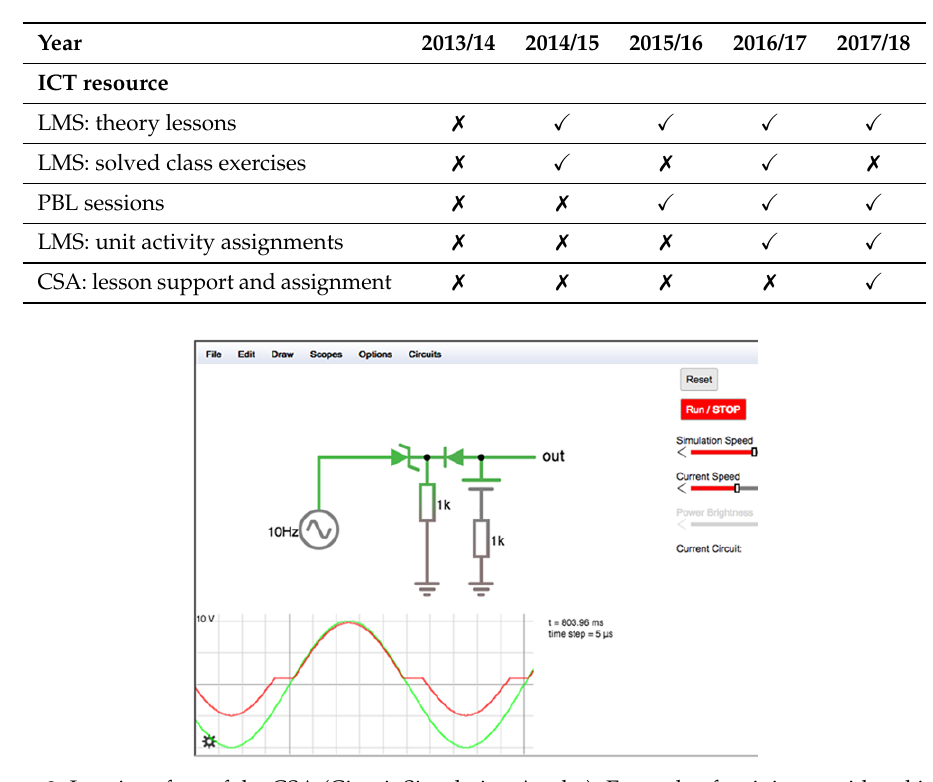
Table 2. Inclusion ( (cid:88) ) of ICT resources per academic year.